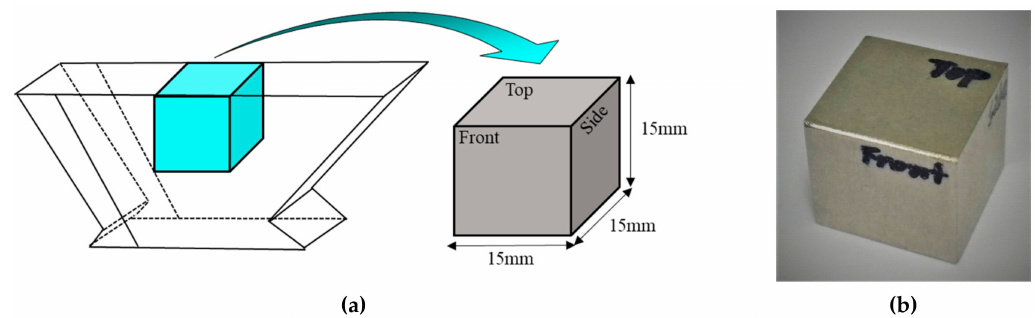
Figure 2. ( a ) Schematic illustration and ( b ) photograph of a coupon specimen of weld